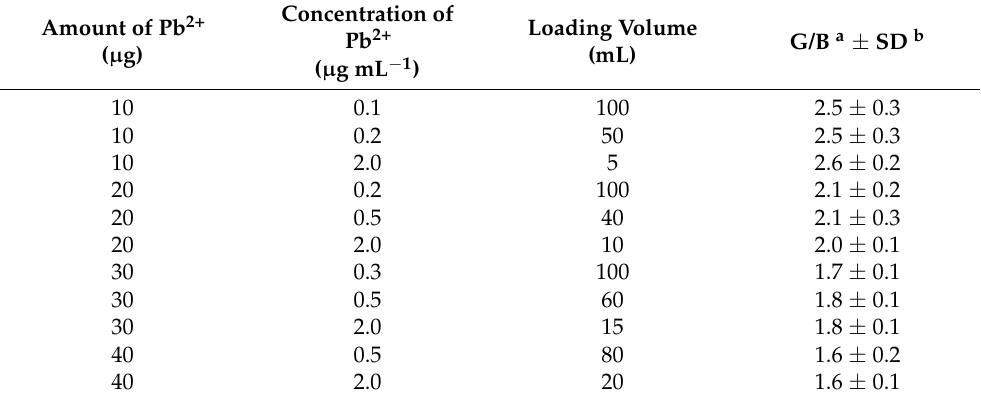
Table 3. Loading Pb 2+ solutions of different concentrations and volumes for single standard calibra- tion ( n =